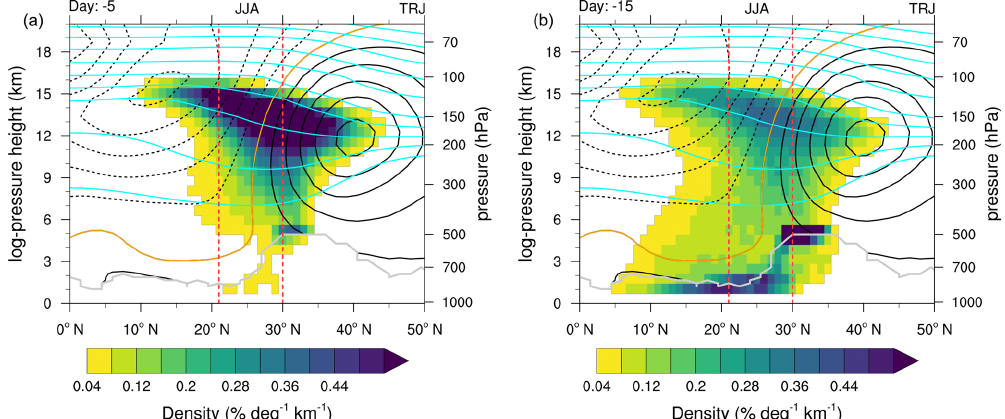
Figure 6. Latitude versus log-pressure height cross sections of density distributions (%deg − 1 km − 1 ) of trajectory positions for PBL crossing trajectories 5 and 15d prior to their arrival at 150hPa within the AMA. The three-dimensional probabilities were integrated over 60–140 ◦ E. Once trajectories reach the PBL they are not tracked further and will also be noted at the crossing point further back in time (as in Fig. 5). Cyan lines indicate potential temperature levels averaged over 0–120 ◦ E starting at 340 to 380K in steps of 10 and 20K afterwards (380 to 480K). Black contours indicate zonal winds averaged over 0–120 ◦ E in steps of 5ms − 1 . Negative, i.e. westward, winds are dashed, and the zero wind line is given in orange. Meteorological data based on ERA-Interim are flagged out below the grey line, which indicates the ERA-Interim minimum surface pressure in the region 0–120 ◦ E of the time average JJA for the trajectory years.